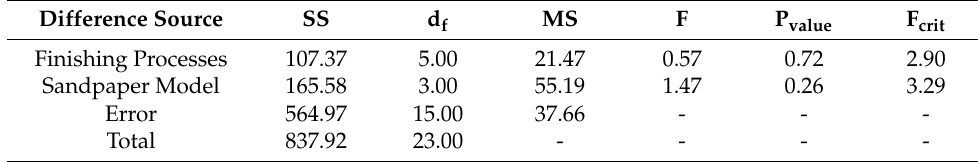
Table 14. Significance analysis of